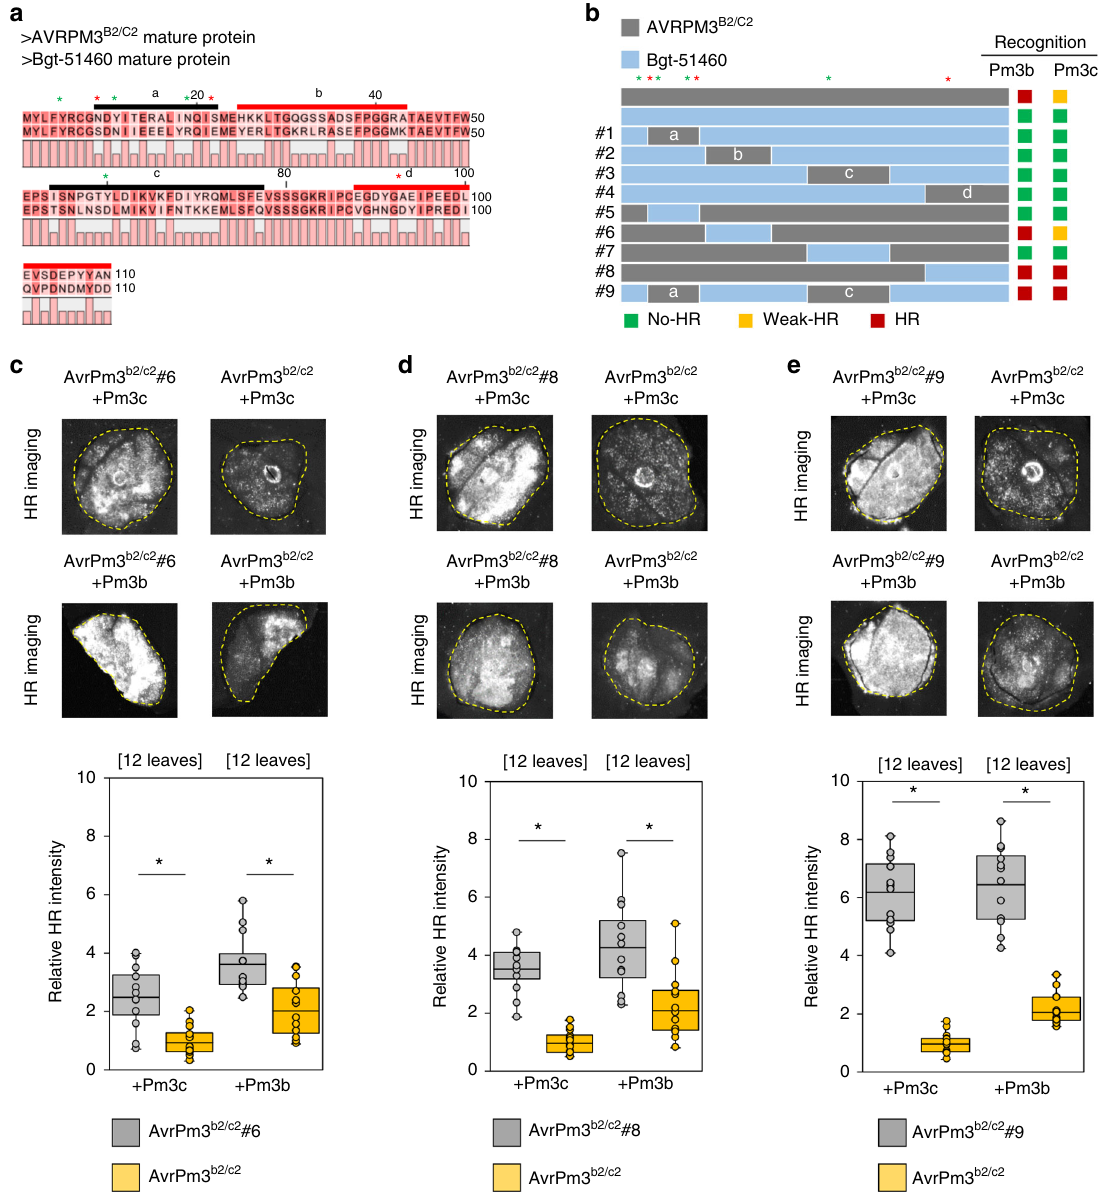
Fig. 5 Consequence of synthetic domain swaps on the recognition of AVRPM3 B2/C2 . a – b Consequence of synthetic domain swaps on the AVRPM3 B2/C2 AVR function. a Protein sequence alignment of the mature protein of AVRPM3 B2/C2 -A and the closest family member Bgt-51460. Swapped domains are indicated and labelled a, b, c and d. Domains that do not abolish AVR recognition when introduced from Bgt-51460 into AVRPM3 B2/C2 are indicated in red. b Schematic representation of the protein domains swapped between AVRPM3 B2/C2 (grey) and Bgt-51460 (blue). a , b Position of the residues identi fi ed from the natural sequence diversity (Fig. 4b, d) are indicated with asterisks. The impact of individual residues on AVR recognition is indicated with green for mutations with a disruptive effect, and red for mutations, with a neutral effect, according to the results summarised in Fig. 4b, d. c – e Transient expression assays in N. benthamiana indicating recognition (upper panel) and HR quanti fi cation (lower panel) for AVRPM3 B2/C2 swaps #6 ( c ), swap #8 ( d ) and swap #9 ( e ) by Pm3c , and Pm3b . The number or independent leaf replicates is indicated. Mean values are indicated by the middle line in the boxplot. Individual data points are plotted along the whiskers delineating minimum and maximum values. Statistical signi fi cance was assessed with a two-sided Student ’ s t -test for paired data and indicated with (* p < 0.05). Complete N. benthamiana leaf pictures and raw data underlying the reported averages are provided in a Source Data